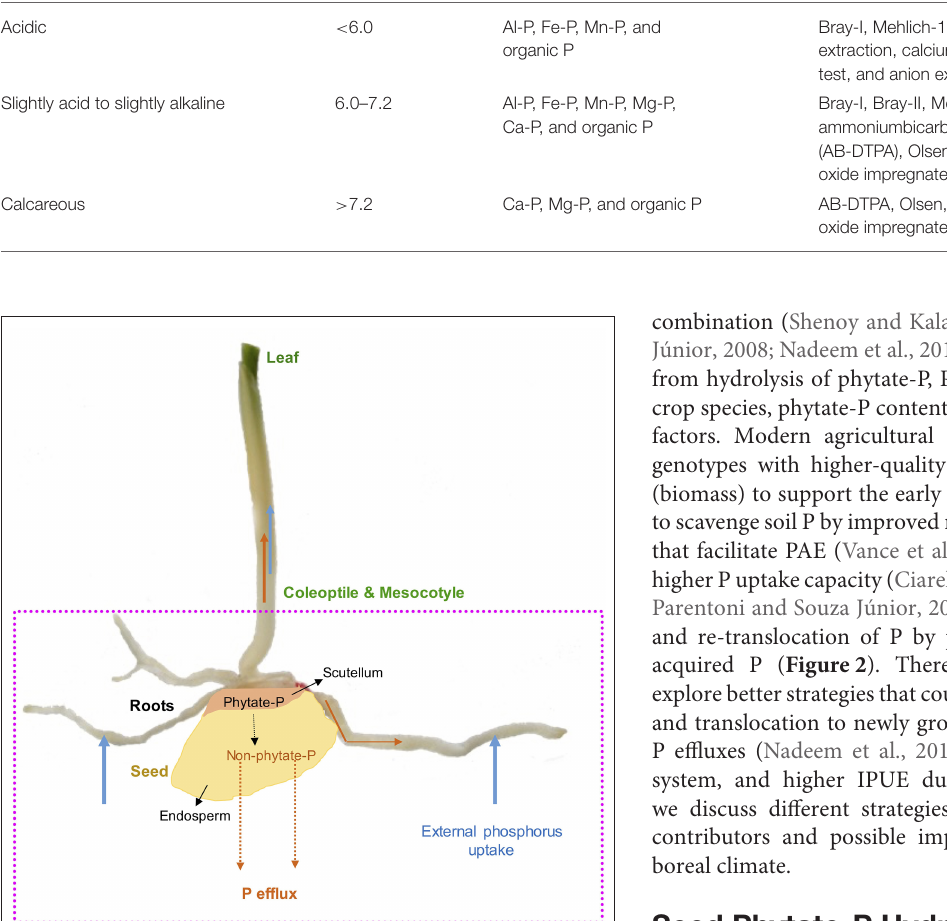
FIGURE 1 | Maize ( Zea mays L. ) as a model seed showing endosperm and scutellum. Seed phytate-P hydrolysis during germination, translocations to developing roots, coleoptile, mesocotyle, and leaves as well as external P uptake and P efflux during germination and early growth